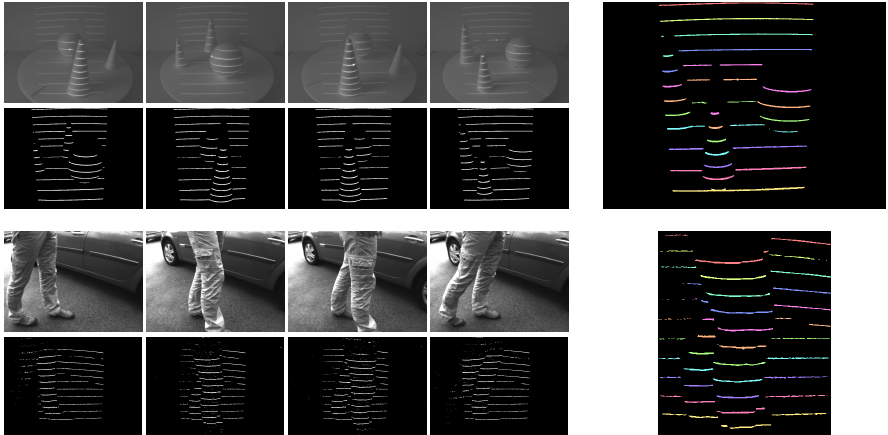
Figure 13. Sample images from the two datasets used in the experiments. The upper group of images shows sample images from the indoor dataset, and the lower group of images shows samples from the outdoor dataset. Both visible-spectrum and demodulated images are shown. The images on the right show the color-coded ground truth (best viewed in